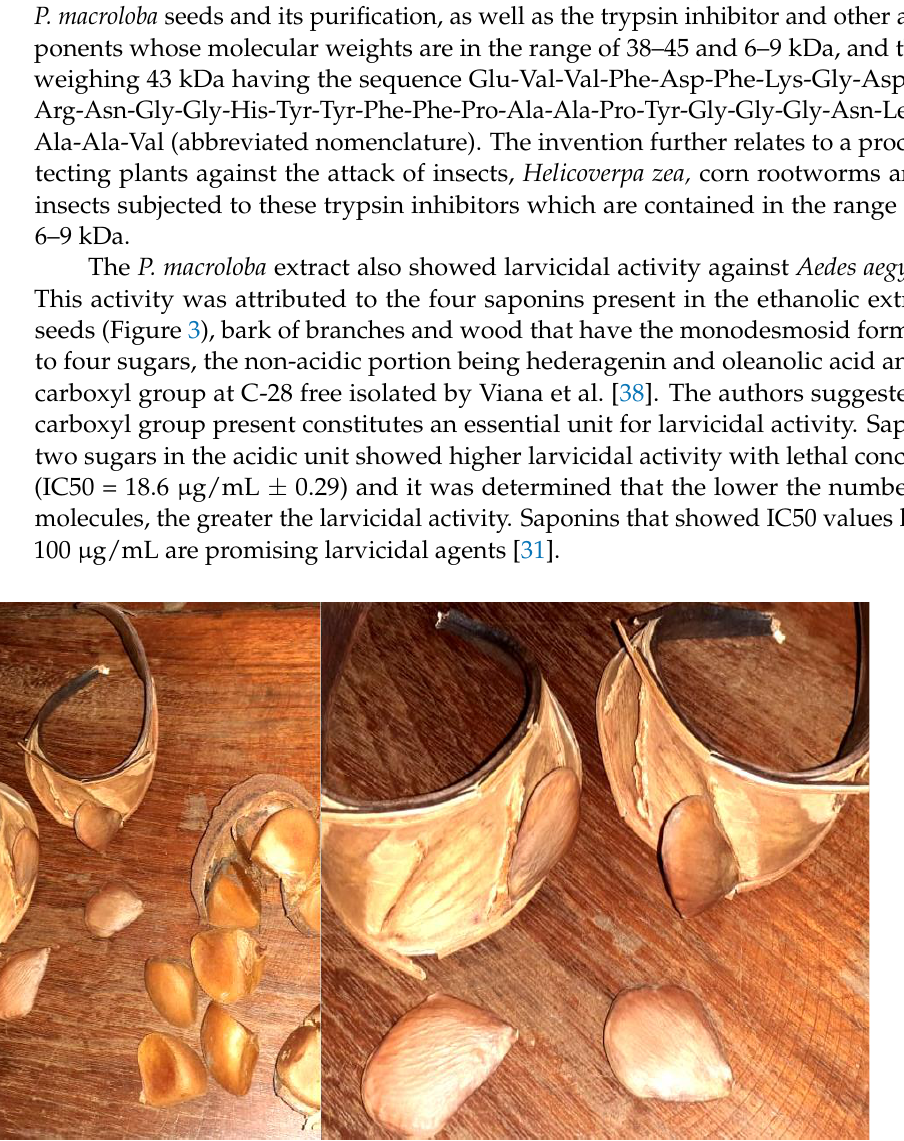
Figure 3. Pracaxi seed harvested from a farm on the island of Marajó, Para in Brazil (By Luiz Morais). Santos et al. [32] carried out studies with oils from Amazonian plants, including pra- caxi, to investigate the insecticidal potential, with a view to controlling the fall armyworm ( Spodoptera frugiperda ); the larvae of this butterfly species cause great economic losses as they attack farms extensively. Pracaxi oil showed efficacy on Spodoptera frugiperda eggs in this